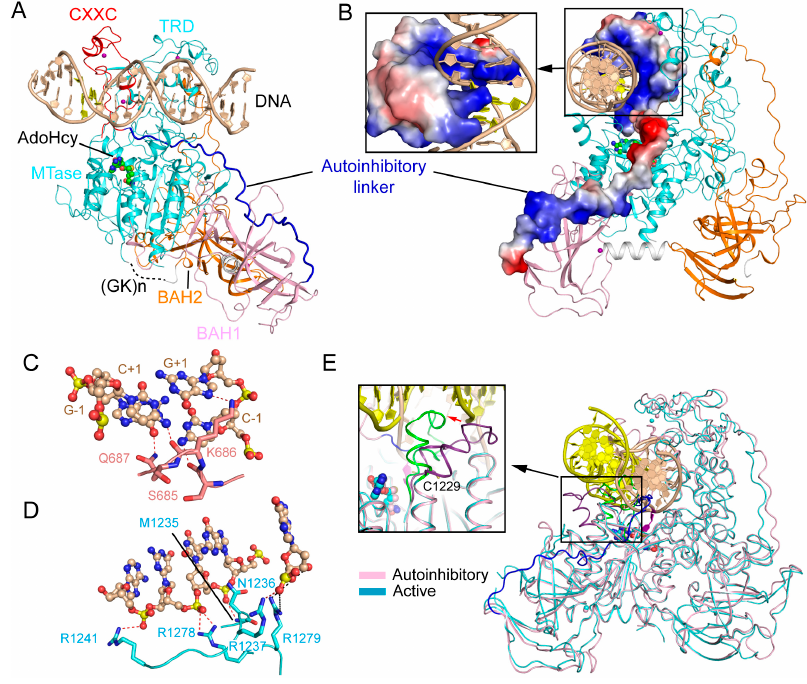
Figure 3. Structural analysis of the CXXC domain-mediated DNMT1 autoinhibition. ( A ) Structural overview of mDNMT1 (amino acids 650–1602) bound to a 19-mer DNA duplex containing unmethylated CpG sites (PDB 3PT6). ( B ) Surface views of the CXXC domain and the autoinhibitory linker in the complex of mDNMT1 with unmethylated CpG DNA. ( C ) Base-specific interactions between the CXXC domain and the CpG site. The hydrogen bonding interactions are depicted as dashed lines. ( D ) The MTase-DNA interactions in the autoinhibitory complex. ( E ) Structural overlay between the active (light blue) (PDB 4DA4) and autoinhibitory (pink) (PDB 3PT6) complexes of mDNMT1, with the catalytic loops highlighted in the expanded